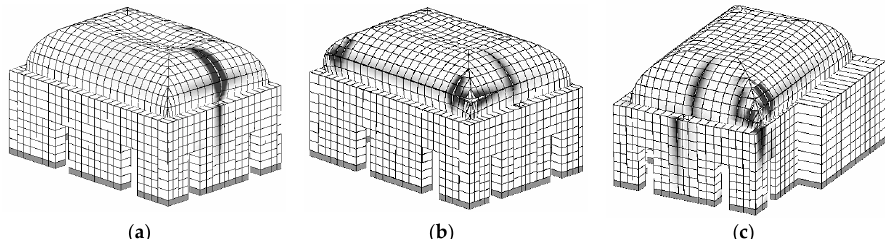
Figure 18. Collapse mechanisms of the mirror vault corresponding to the application of: vertical actions (push down analysis) ( a ); and horizontal actions (push over analyses, along the: longitudinal ( b ); and transversal direction ( c ).